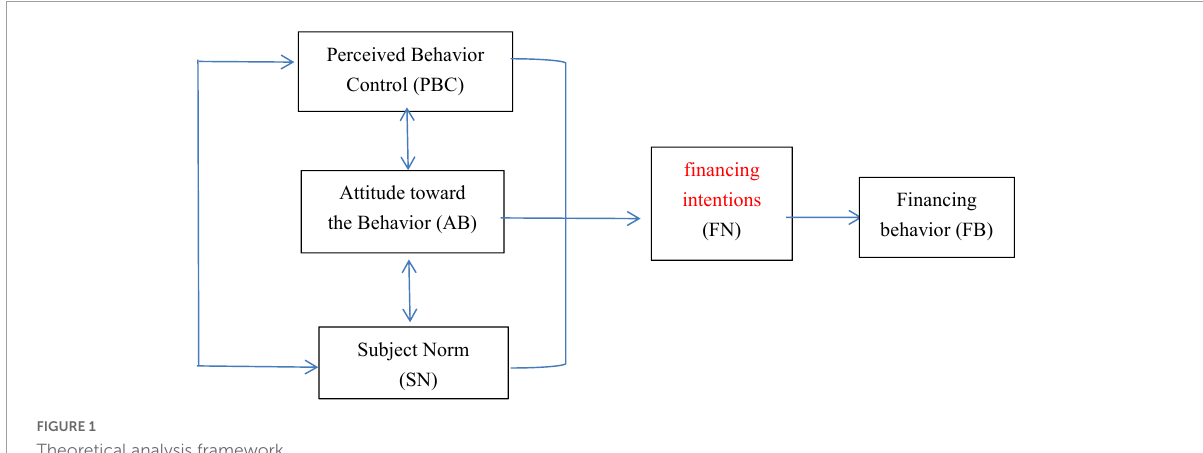
FIGURE1 Theoretical analysis